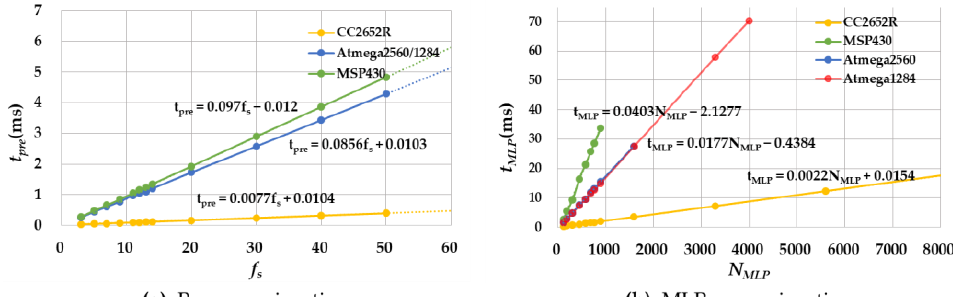
Figure 9. Comparison of preprocessing and MLP time.